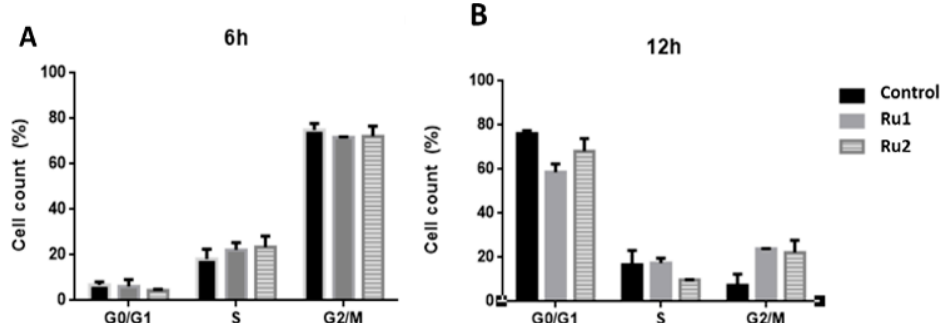
Figure 5. Effect of Ru1 , Ru2 or 0.1% ( v / v ) DMSO on the cell-cycle progression of MCF7 cell line. Cells were synchronized and exposed to a 0.1% ( v / v ) DMSO solution (vehicle control) or the IC 50 concentrations of each compound for 6 h ( A ) and 12 h ( B ). The fluorescence content was analyzed by flow cytometry, after staining with propidium iodide (PI, excitation and fluorescence emission at 493 and 636 nm, respectively). The data are presented as the mean ± SEM of three independent experiments.